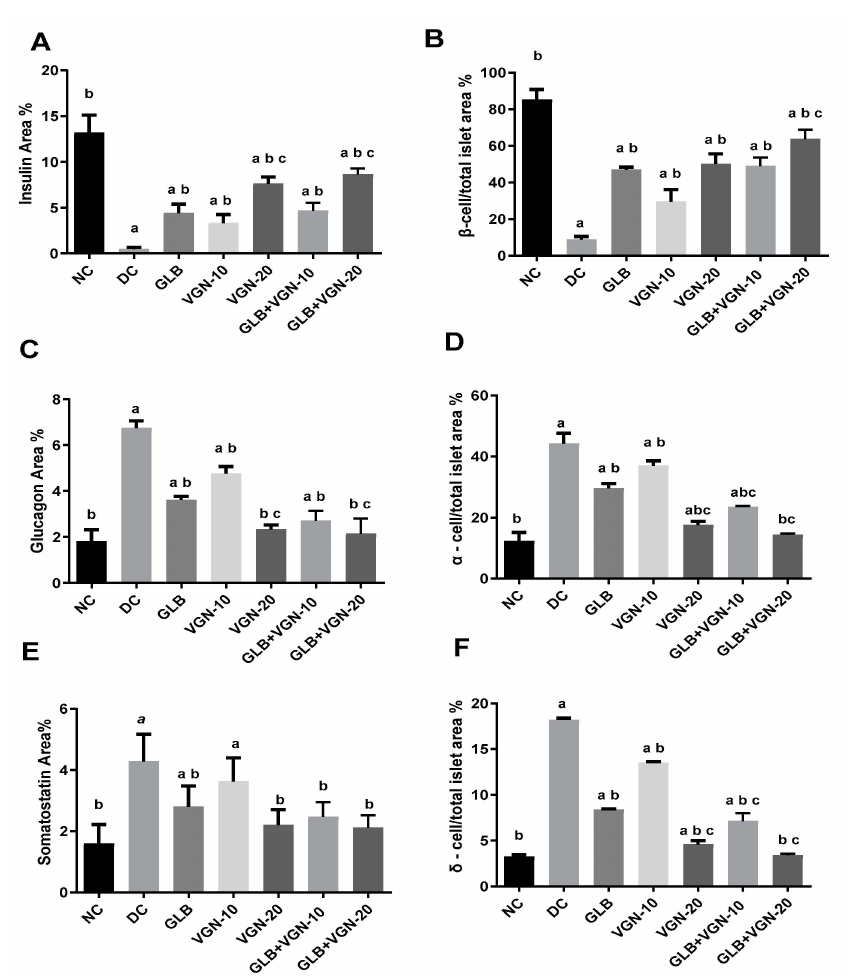
Figure 4. Morphometric analyses of islets of Langerhans’ composition: ( A ) insulin content of β - cells; ( B ) β -cell/total islet area %; ( C ) glucagon content of α -cells %; ( D ) α -cell/total islet area %; ( E ) glucagon content of δ -cells %; ( F ) δ -cell/total islet area %. Values are expressed as the mean ± S.E (n = 6). a,b,c refer to significant changes at p ≤ 0.05 with respect to NC, DC and GLB groups,